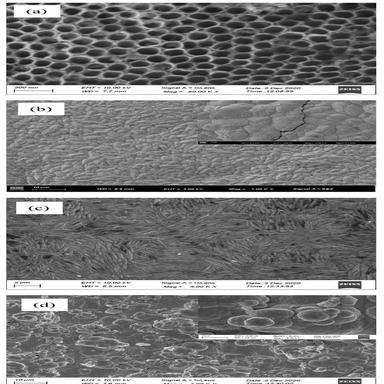
SEM micrographs of anodes: (a) Blue-TiO2-NTs middle layer; (b) Blue-TiO2/PbO2 electrode; (c) Blue-TiO2/PbO2-CTAB electrode; (d) Blue-TiO2/PbO2-